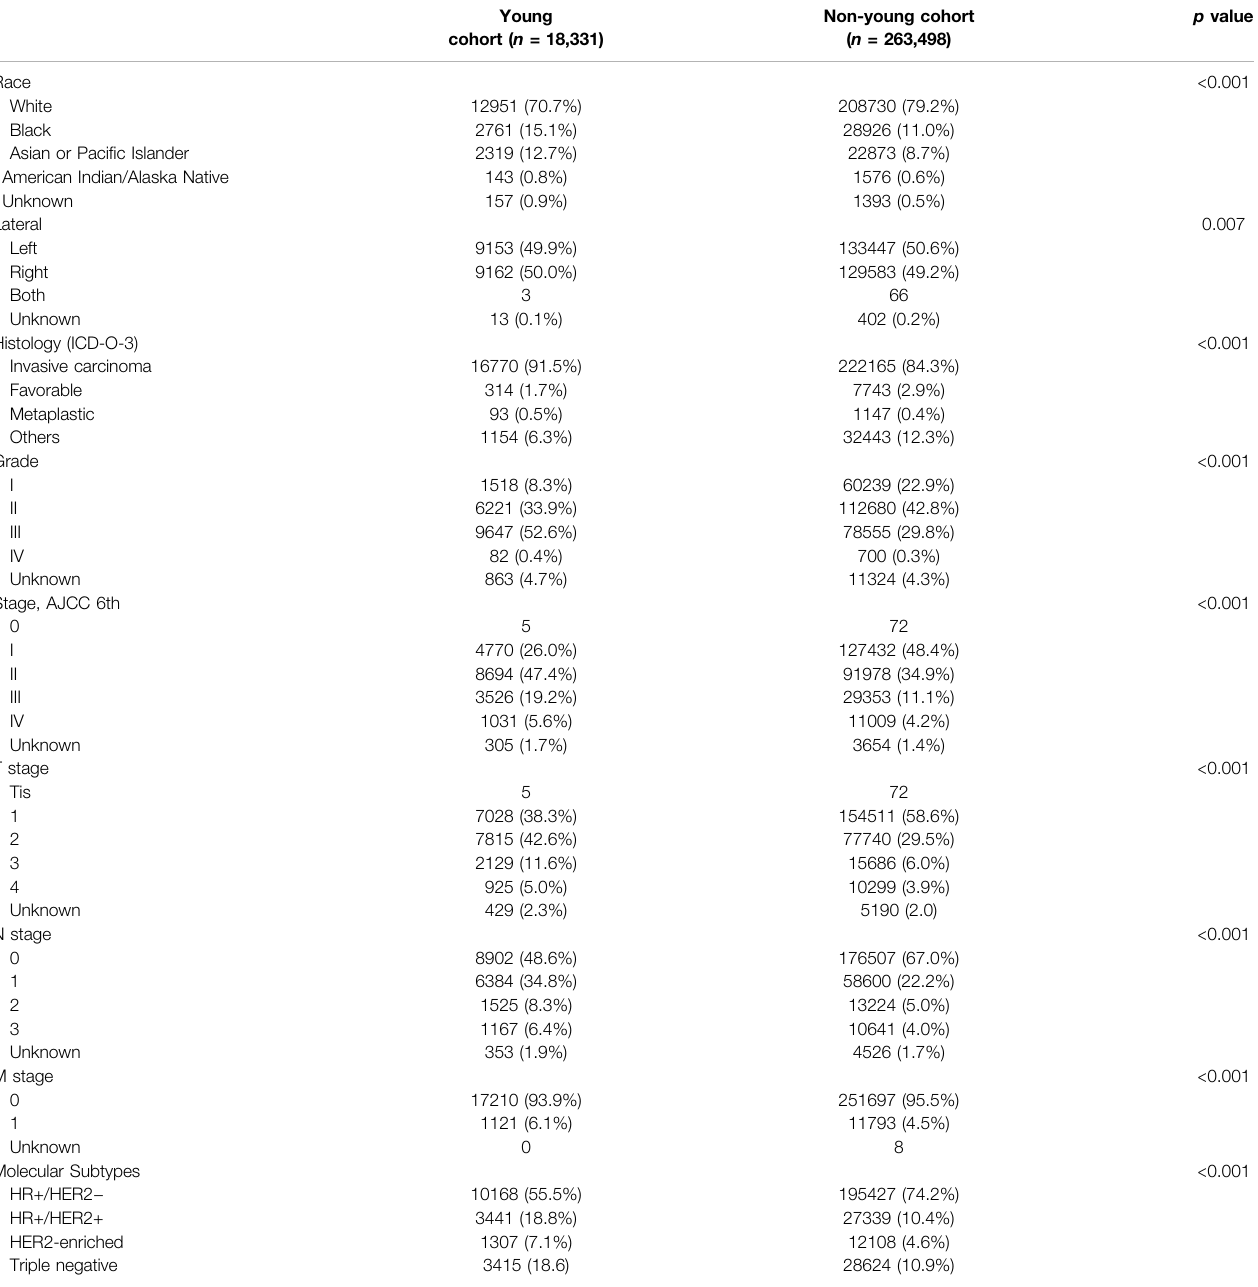
TABLE 1 | Patient characteristics of the young cohort and the non-young cohort.